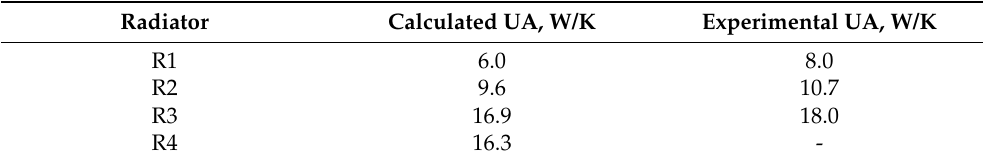
Table 4. Calculated by Equations (1)–(3) and experimentally measured [30] values of UA for tested radiators at working conditions of adsorptive air conditioning cycle.